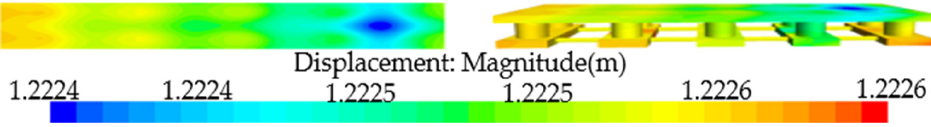
Figure 6. Deformation under non-operational sea state.